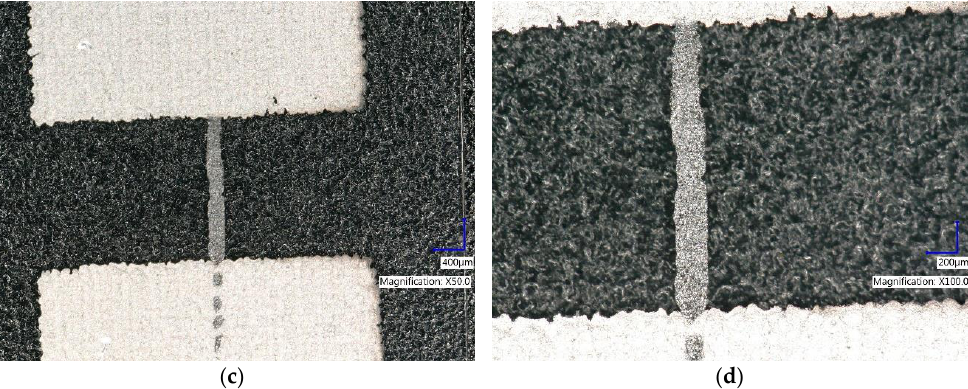
Figure 8. Graphene printed paths ( a , b ) produced using nondispersant ink ( c , d ) produced using ink with dispersing agent. The graphene paths were printed using piezoelectric inkjet printer with parameters: nozzle diameter: 50 µm, voltage: 40–50 V, pulse length: 150–200 µs. Patterns printed with graphene nondispersant ink have blurry edges. At the edges, instead of a uniform layer, single agglomerates of graphene flakes are visible. The resulting sample is non- homogeneous and exhibiting higher sheet resistivity of 125 𝑘Ω . Due to better dispersion of GNPs and □